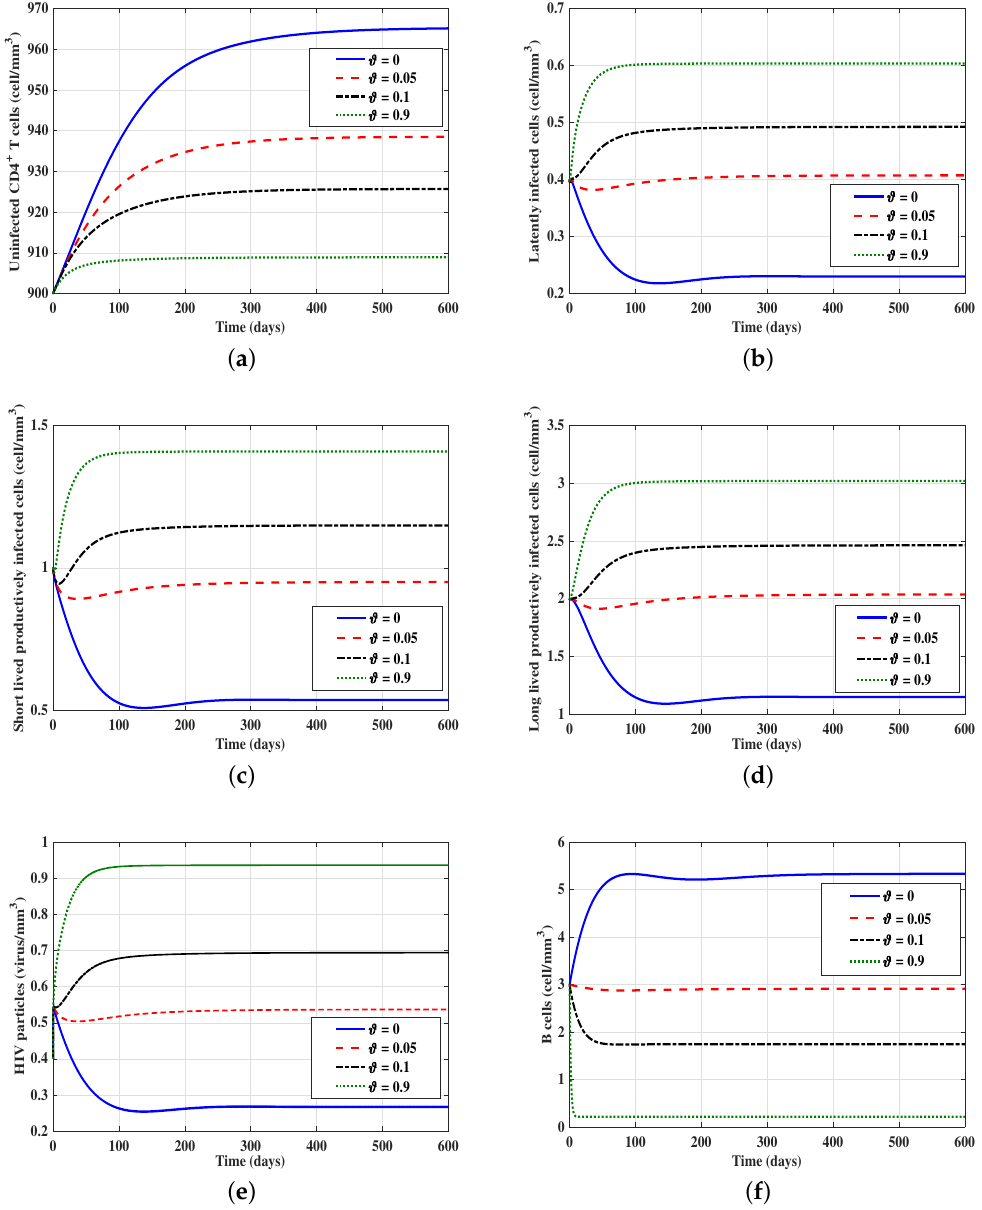
Figure 3. Effect of the B-cell impairment parameter ϑ on the solution trajectories of models (15)–(20) with initial condition IC5. In this figure, we take α 2 = 0.5, λ = µ = 0.01, and α 1 = 0.001. ( a ) The behavior of uninfected CD4 + T cells; ( b ) the behavior of latently-infected cells; ( c ) the behavior of short-lived productively-infected cells; ( d ) the behavior of long-lived productively-infected cells; ( e ) the behavior of HIV particles; ( f ) the behavior of